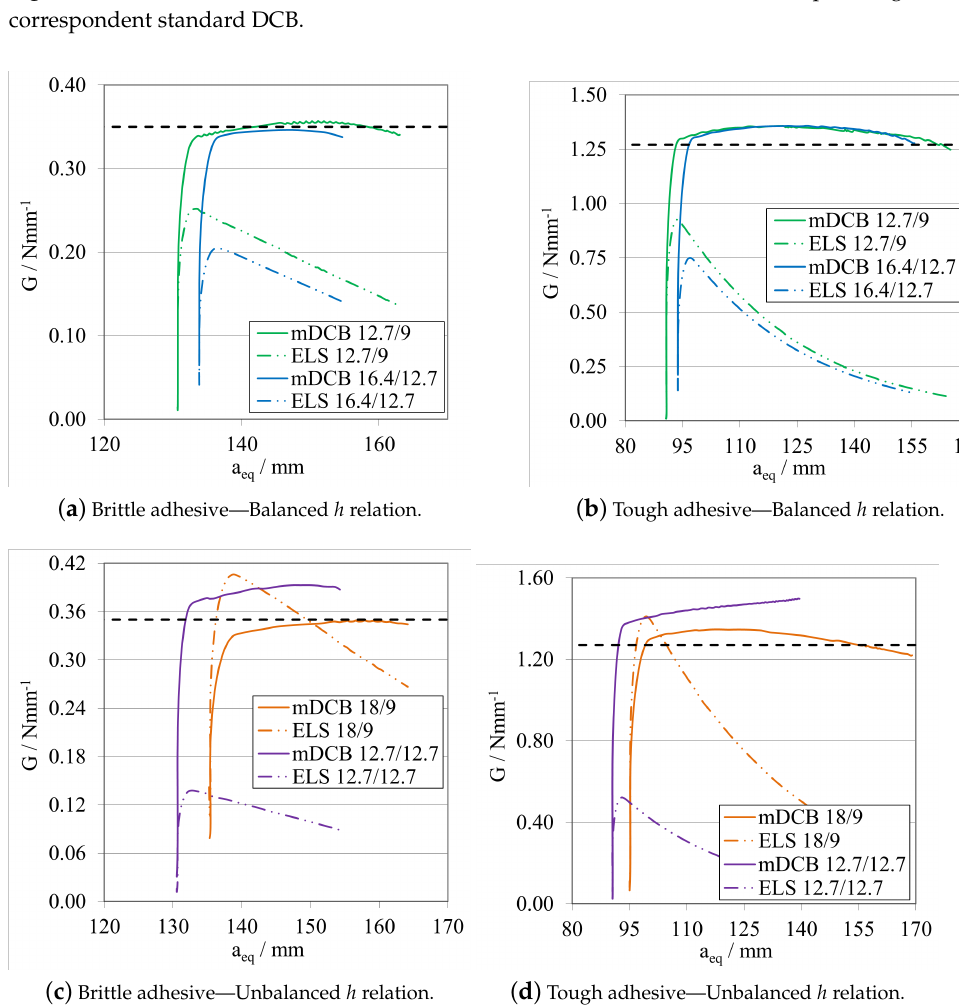
Figure 27. R-curves related to several combinations of h ELS and h mDCB , compared against the correspondent standard DCB, analysed through the novel mDCB CBBM data reduction scheme. Black dashed line represents the input G IC